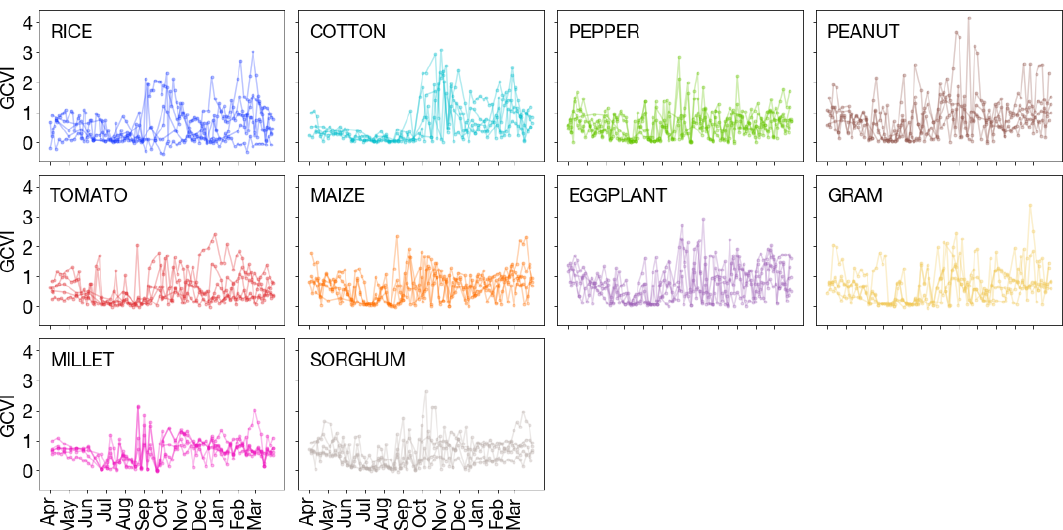
Figure 2. Raw Sentinel-2 time series. For each crop type, the green chlorophyll vegetation index (GCVI) of Sentinel-2 time series at 5 randomly sampled submissions are shown from 1 April of the crop year to 31 March of the next year. GCVI is defined as NIR/green − 1 and measures chlorophyll concentration in